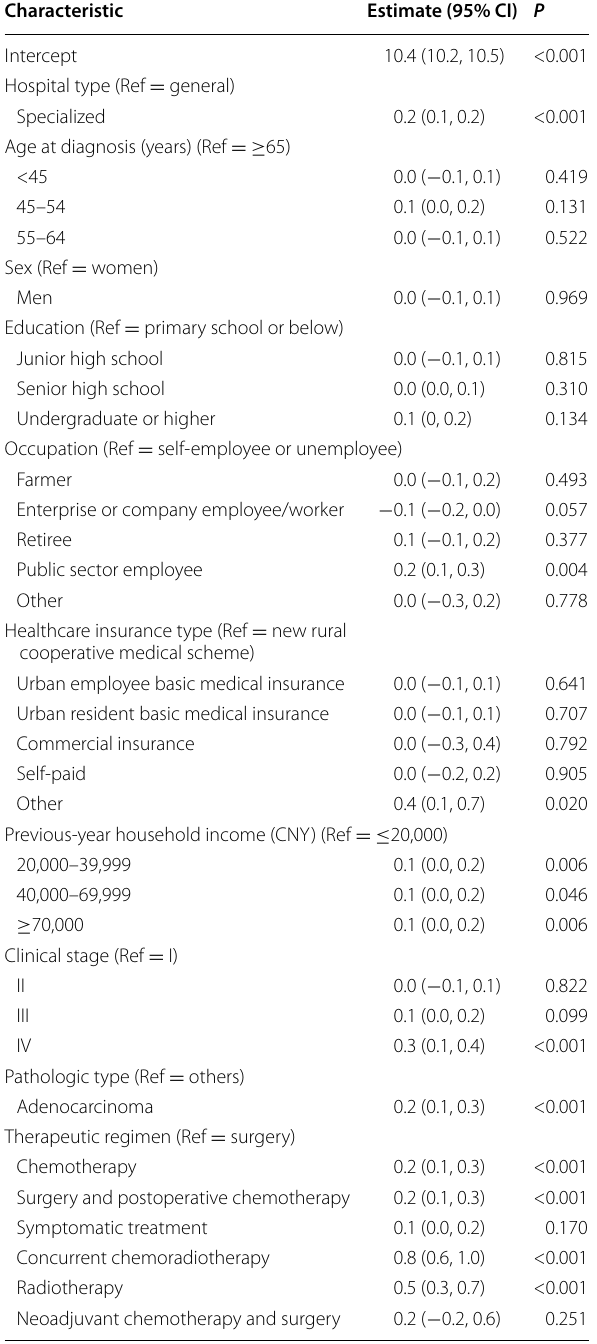
Table 4 Multivariate analysis of overall expenditure for diagnosis and treatment of 2356 patients with colorec-